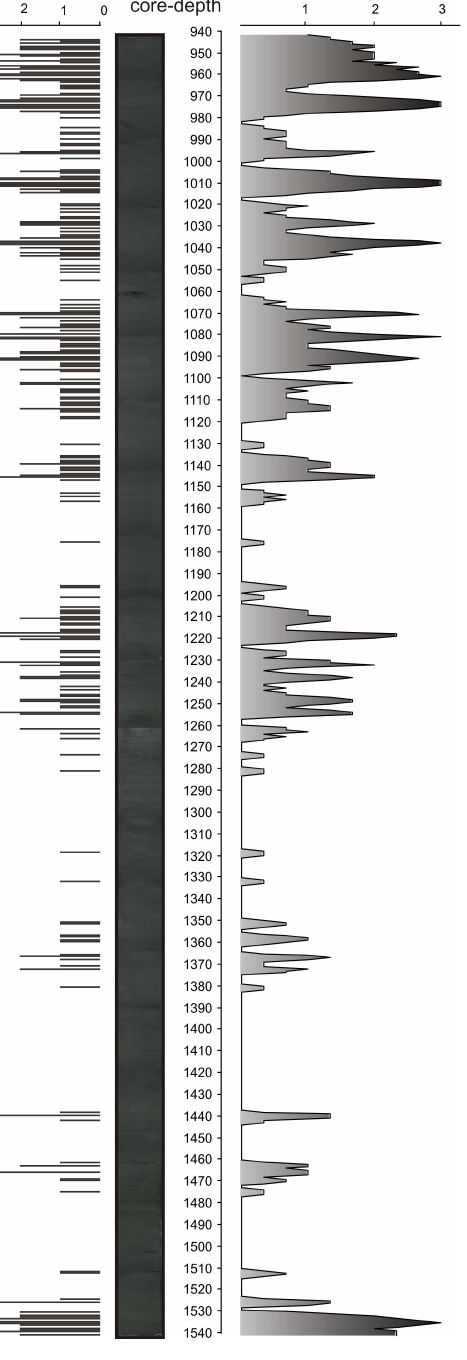
Fig. 2. Illustration of the core and relative dreissenid abundance in- dicated on a semi-quantitative scale (0 = no shells; 1 = rare debris or single shells; 2 = loose coquina; 3 = dense shell bed), left: raw data, right: 3 point-running mean; core depth in cm (corresponds to sample numbers 1540–940; i.e. 600